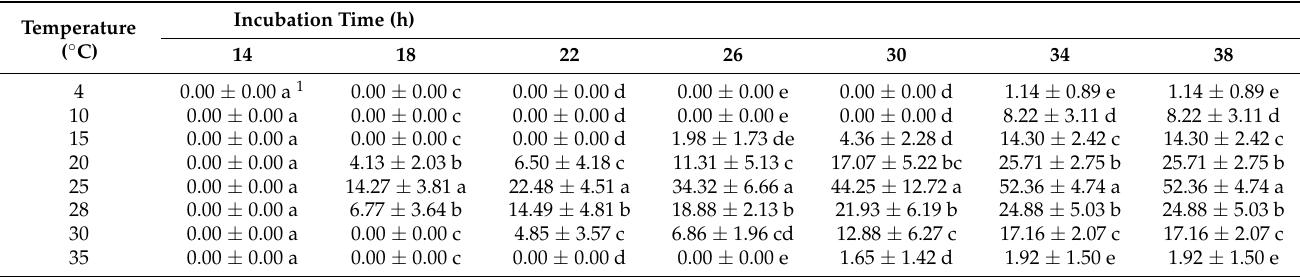
Table 5. Conidial germination rate (%) of Paraphoma radicina at varying temperatures and measured across seven time